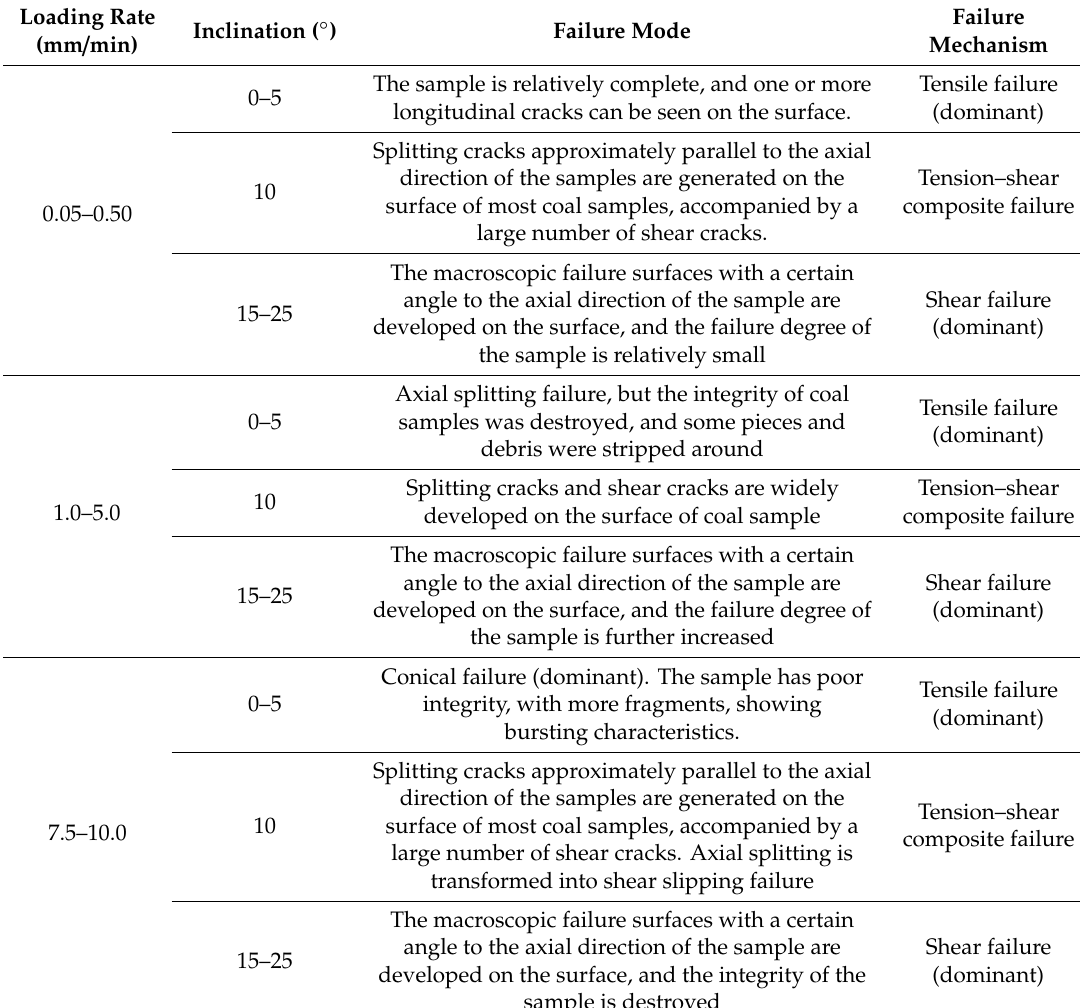
Table 4. Failure characteristics of coal samples under various loading rates and inclination angles. Loading